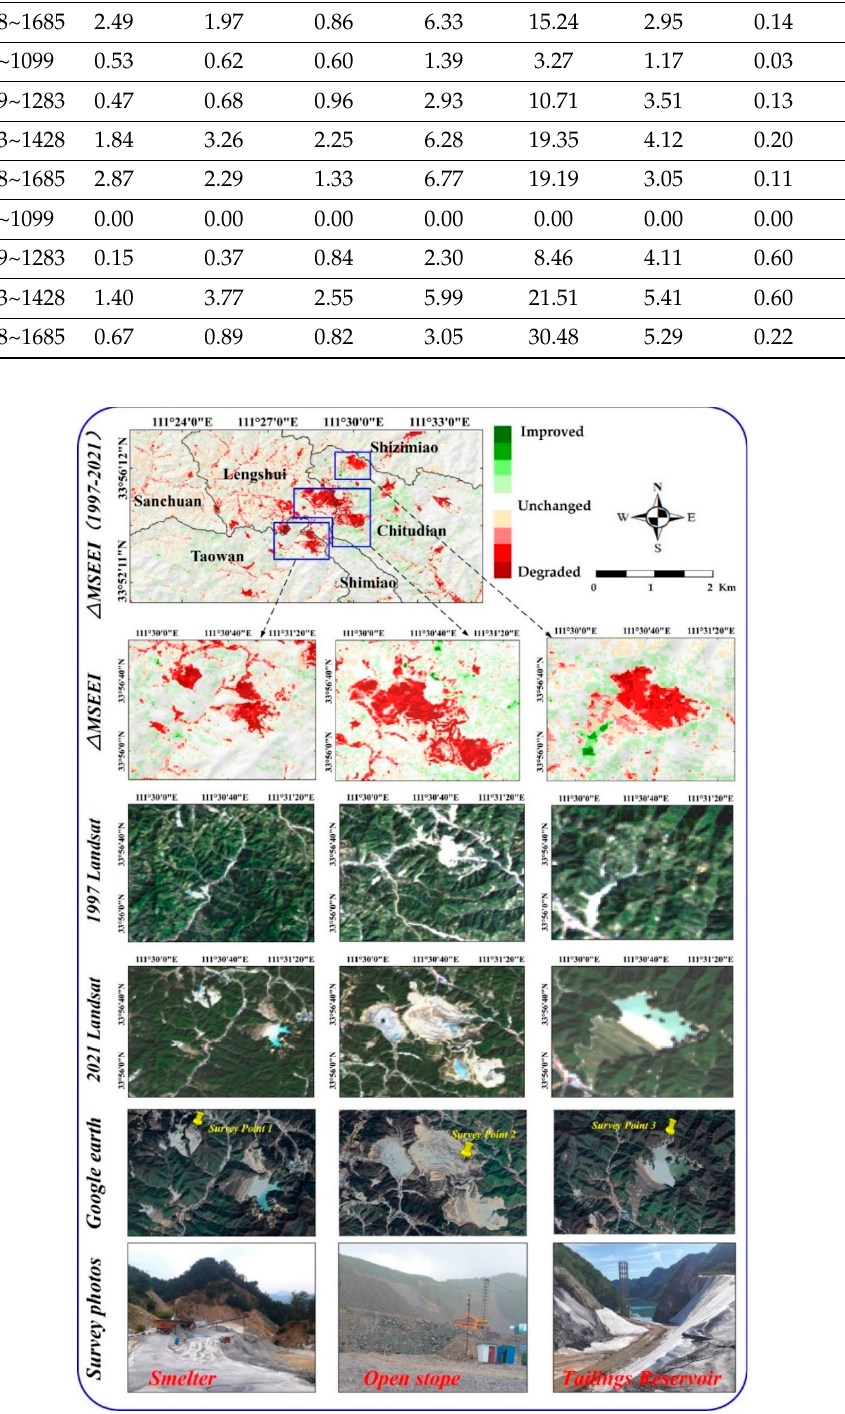
Figure 11. Field inspection and investigation of degraded areas.